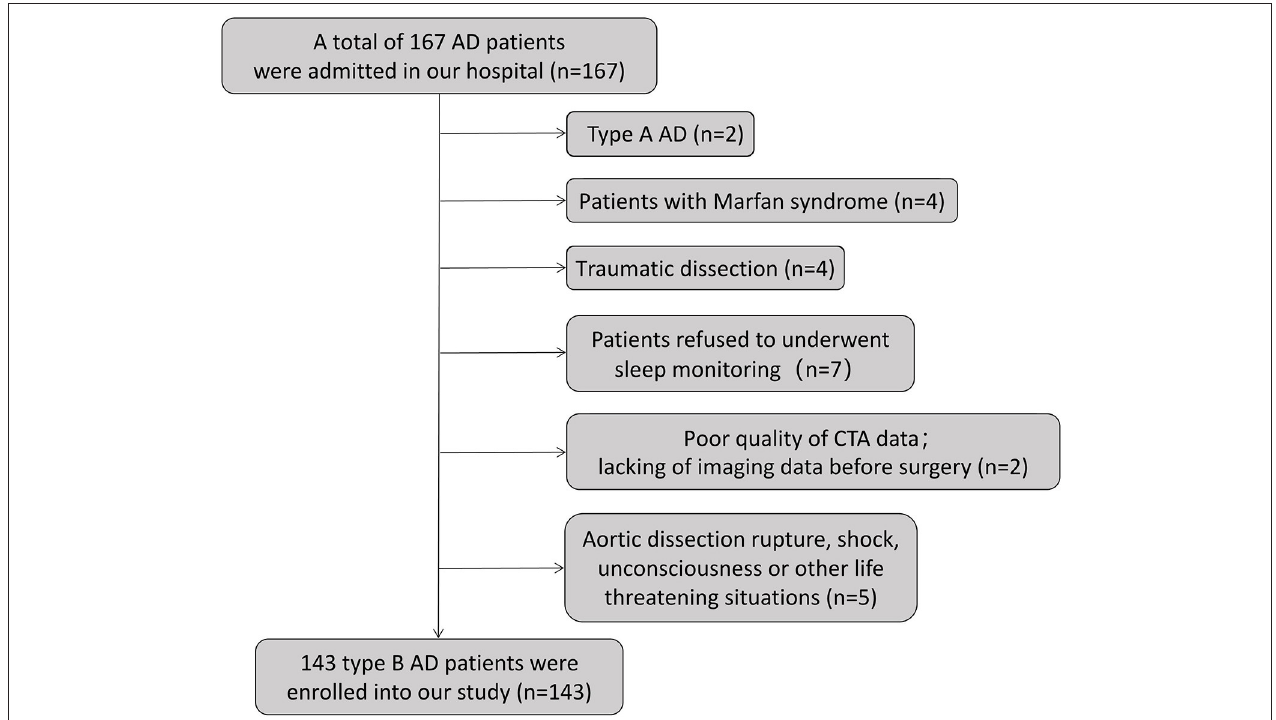
FIGURE 1 | Flow chart of the exclusion